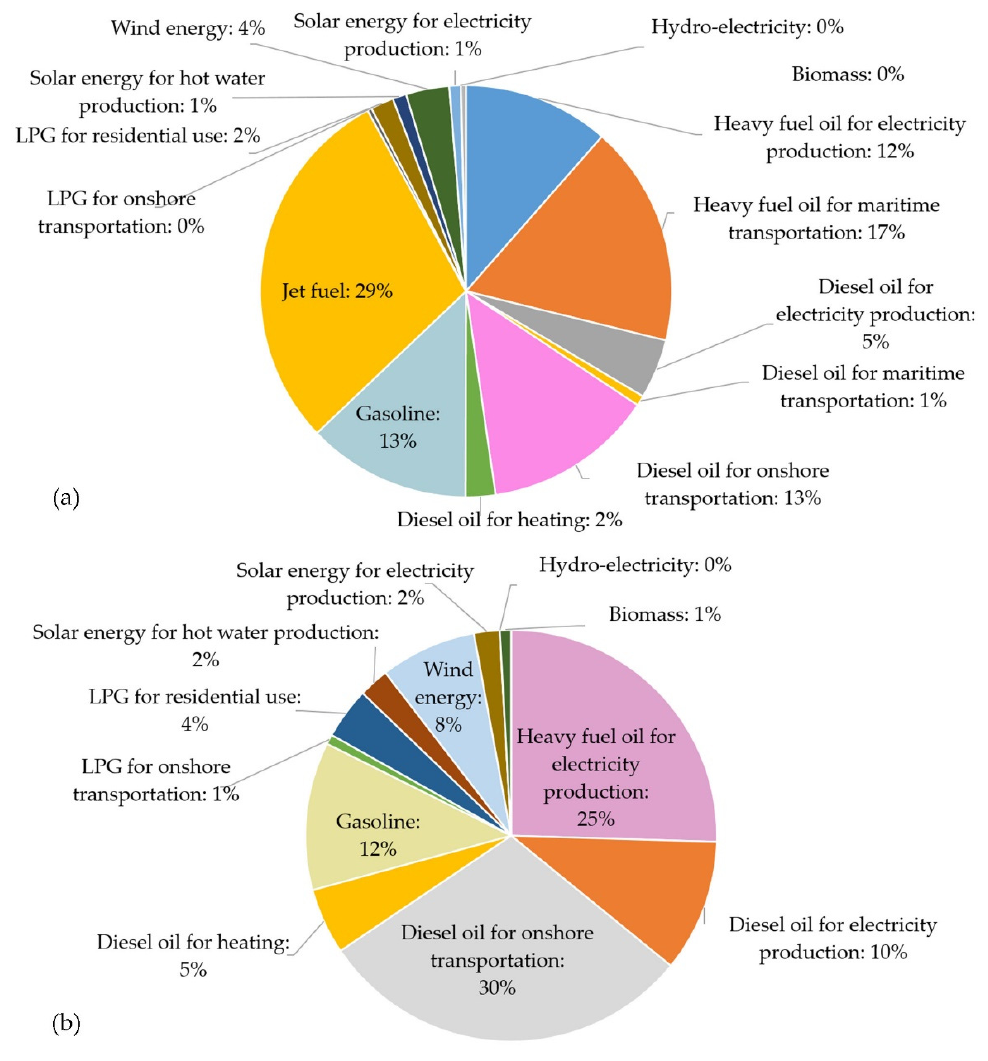
Figure 10. Percentage contribution of energy sources for the final energy use in Crete ( a ) for the overall energy sectors, ( b ) only for the onshore energy sectors.